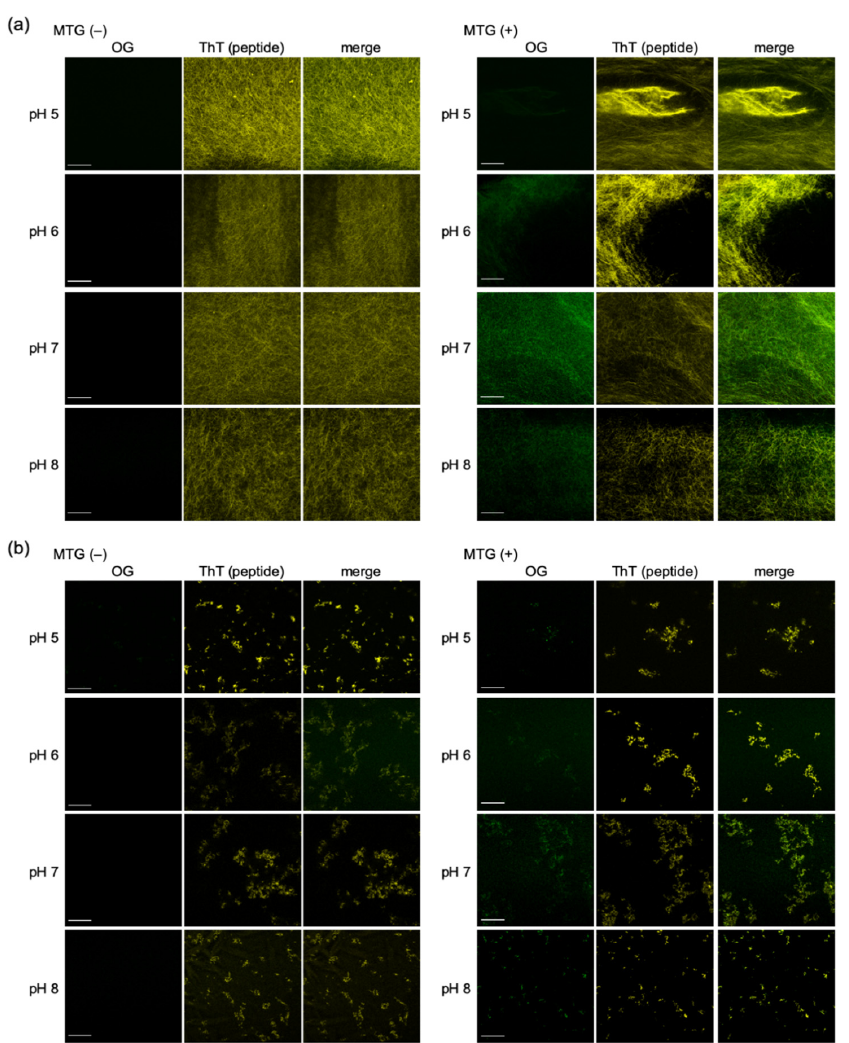
Figure 6. C onfocal laser scanning microscopy (CLSM) images of Fmoc-L 2 QG ( a ) and Fmoc-L 3 QG ( b ) assemblies at pH 5–8 with and without the MTG reaction. Green fluorescence derived from Oregon green 488 cadaverine (OG) was observed at the overlap region with the fluorescence of thioflavin T (ThT)-stained peptide amphiphile (PA) assemblies for samples with the MTG reaction. Bars: 20 μ m.